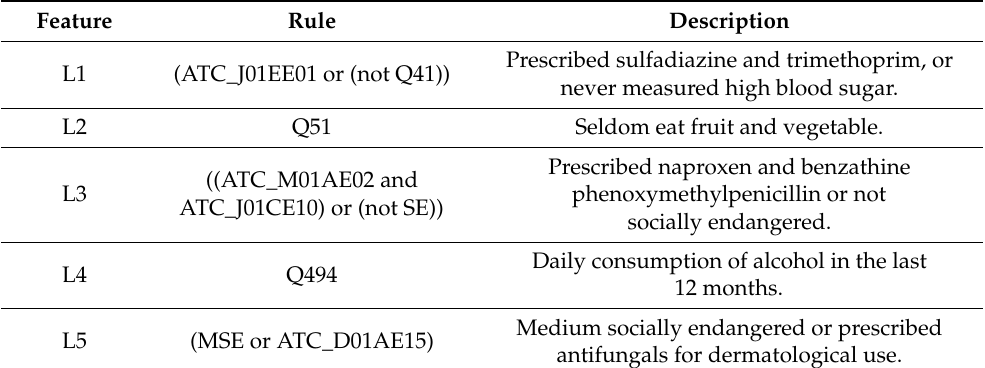
Table 2. Extracted logic features with corresponding LogicRegression rules and descriptions.